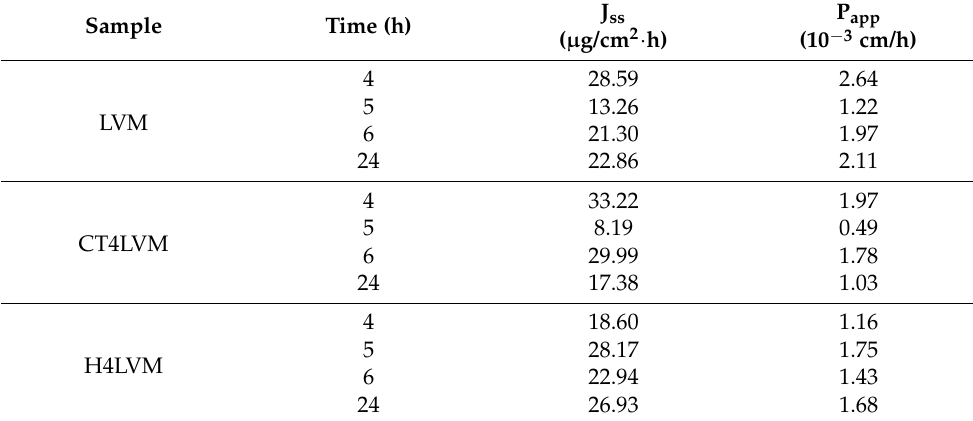
Table 4. In vitro permeability parameters: steady-state fluxes, and apparent permeability coefficients of Curcumin loaded in microemulsion and gel microemulsions.